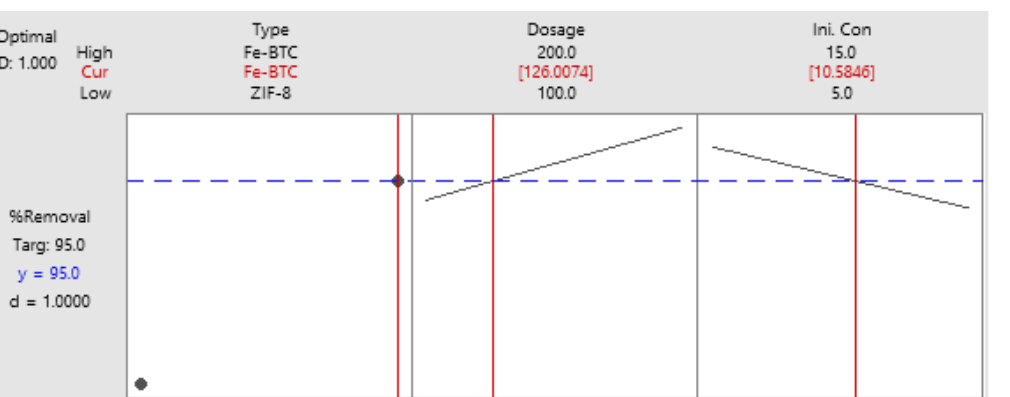
Figure 14. Contour plot of dye removal showing the interaction of Fe-BTC dosage and MO initial concentration.